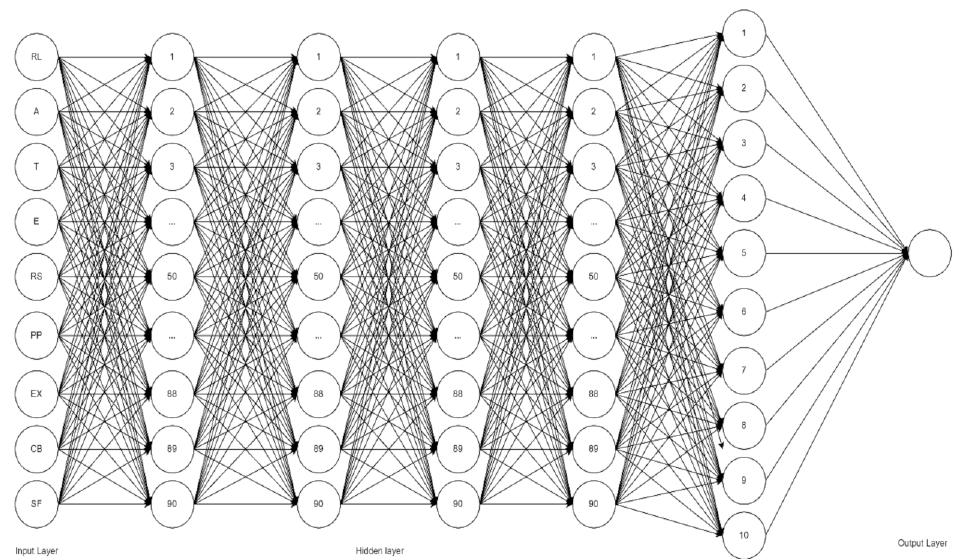
Figure 6. Deep Learning Neural